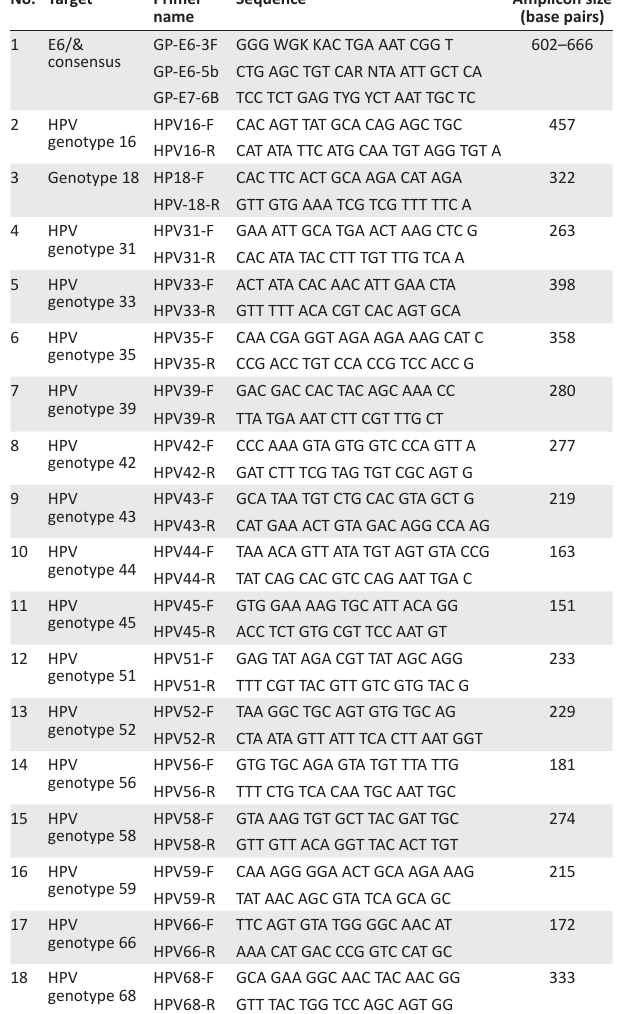
TABLE 2: Age distribution of dental clinic attendees in Ibadan, Nigeria, January 2016 to March 2017.